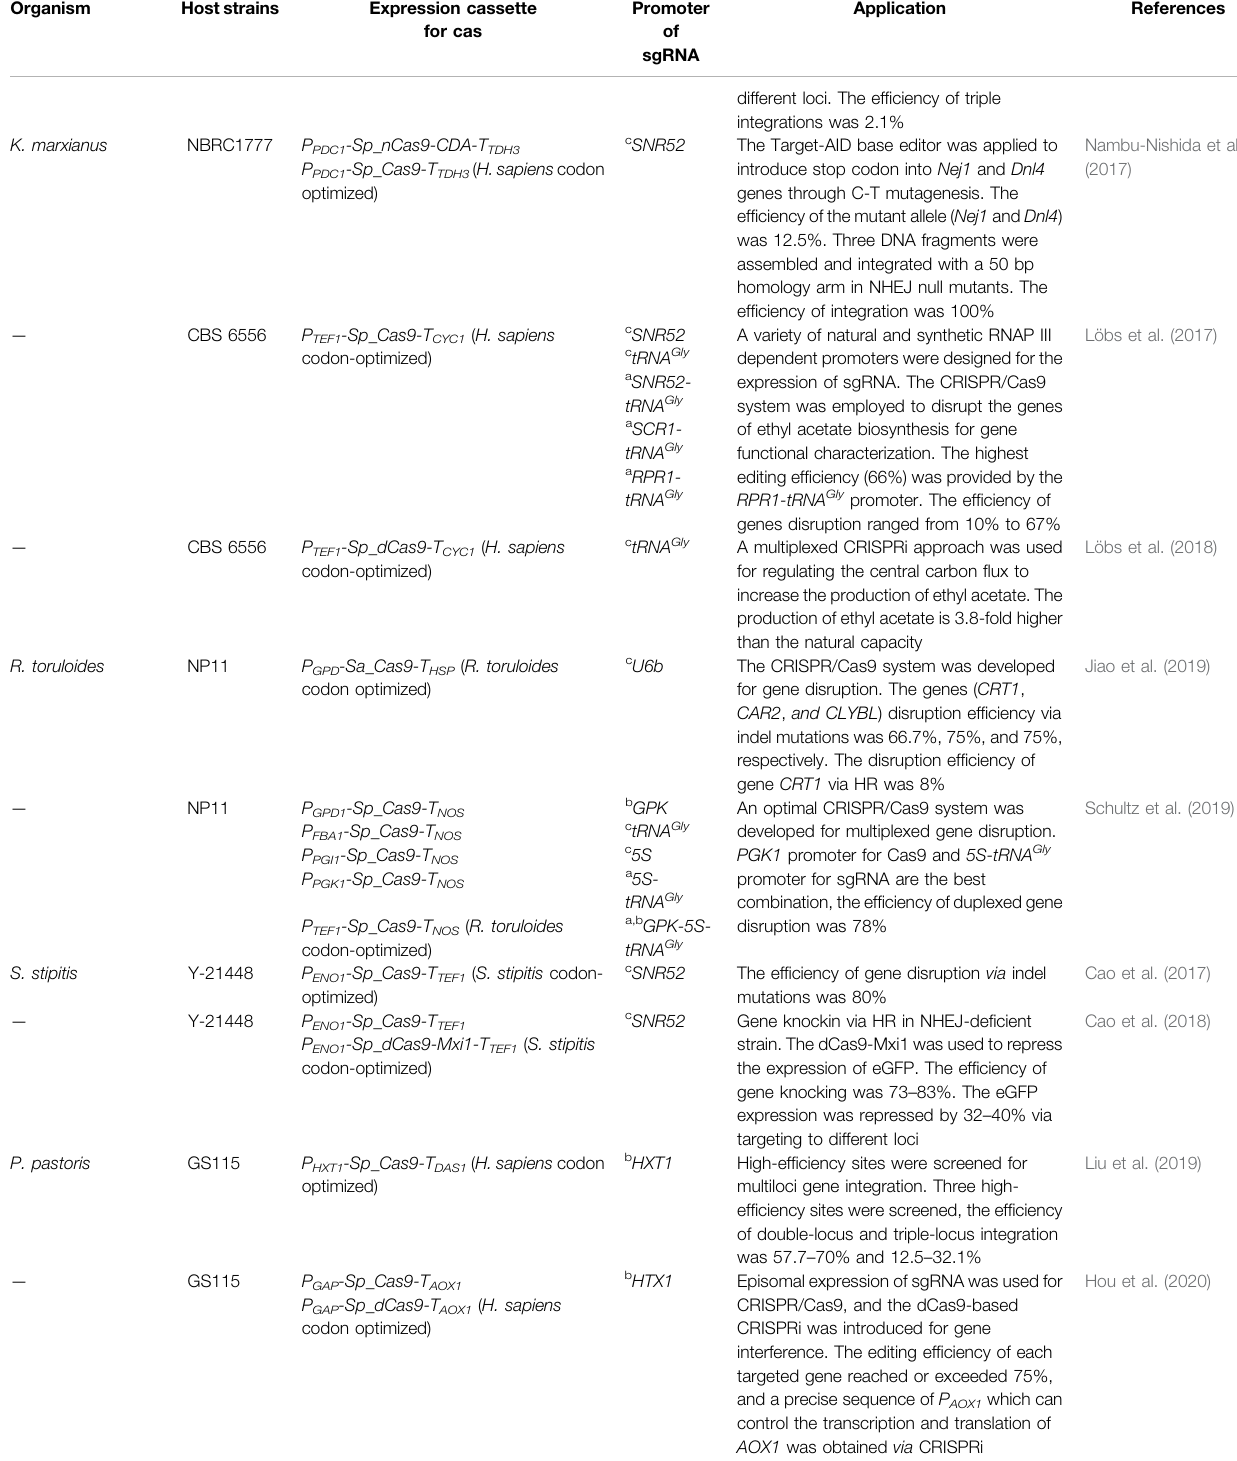
TABLE 1 | ( Continued ) Genetic editing applications of CRISPR/Cas in non-conventional